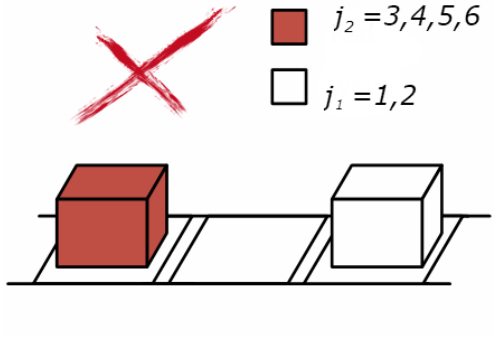
Figure 5. Diagram of Restriction C1.